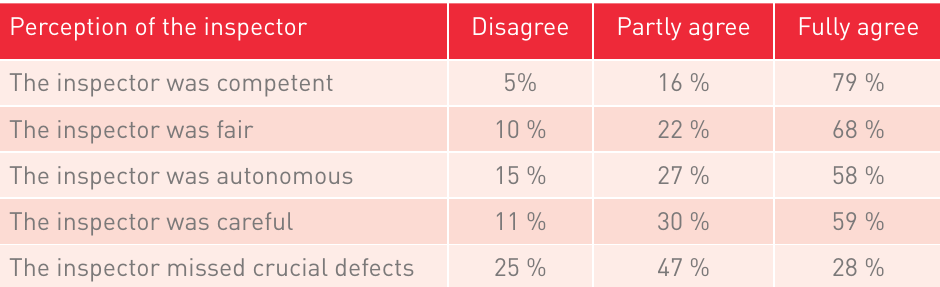
Perception of the